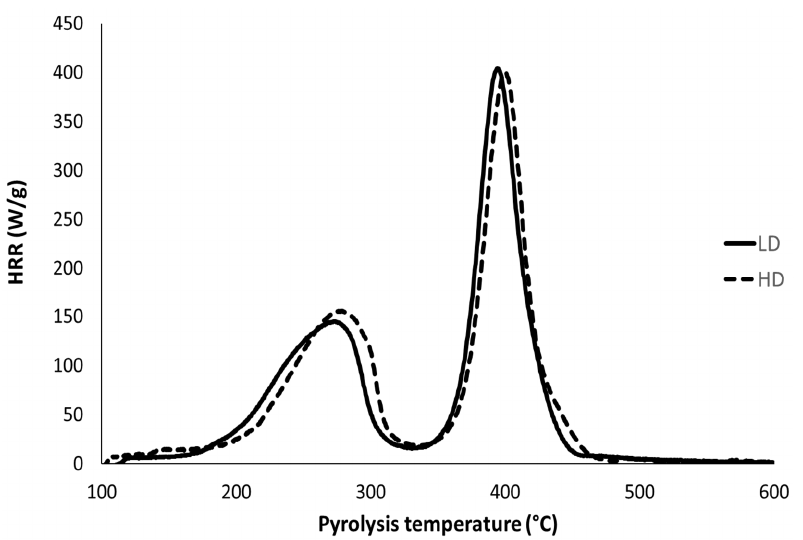
Figure 3. Heat release rate curves of both foams in pyrolysis–combustion flow calorimetry. Table 2. Main data from pyrolysis–combustion flow calorimetry on both foams.